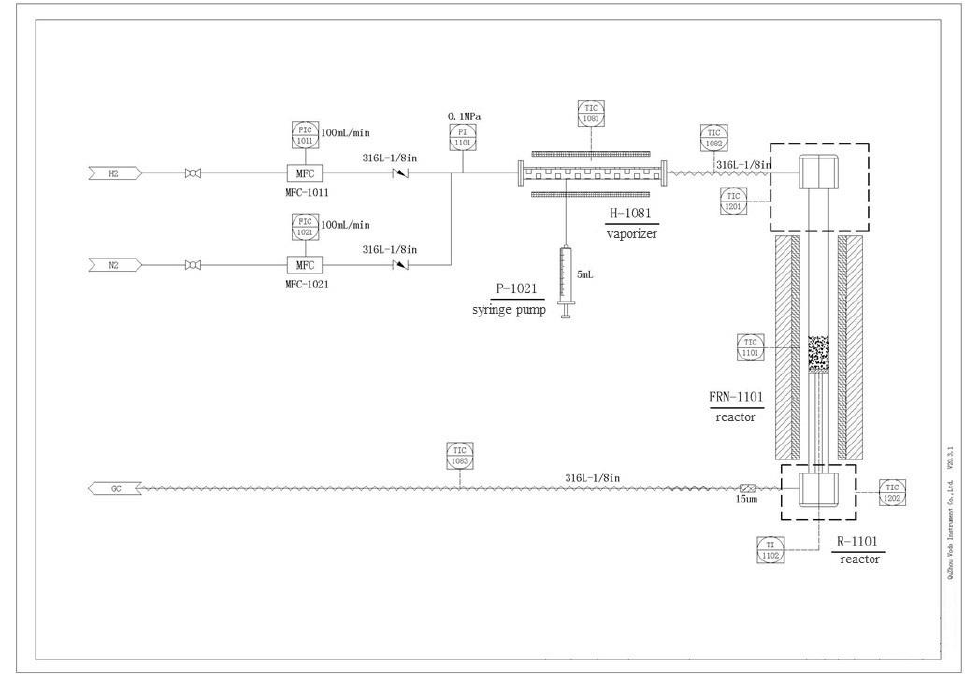
Figure 10. Micro device PID model diagram.